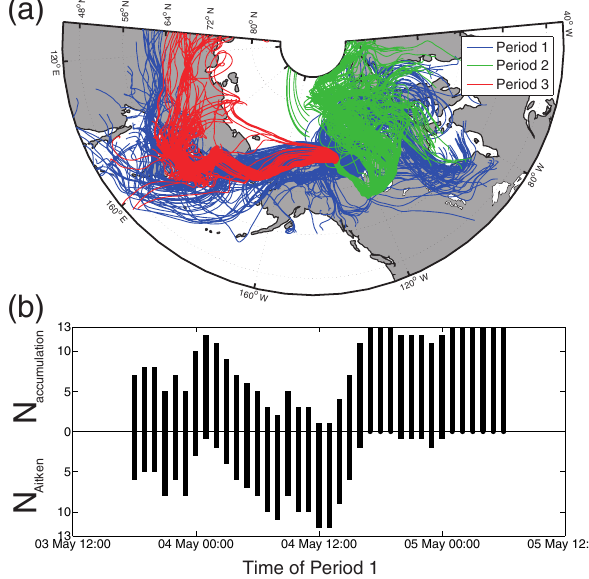
Figure 6. (a) Ten-day back trajectories of the three periods started in and around Tuktoyaktuk at a pressure level of 25hPa above the surface pressure. (b) The total number of 13 trajectories per hour of Period 1 was split up into the number of trajectories that came from east ( N accumulation ) or west ( N Aitken ) to illustrate the alternation of the air mass